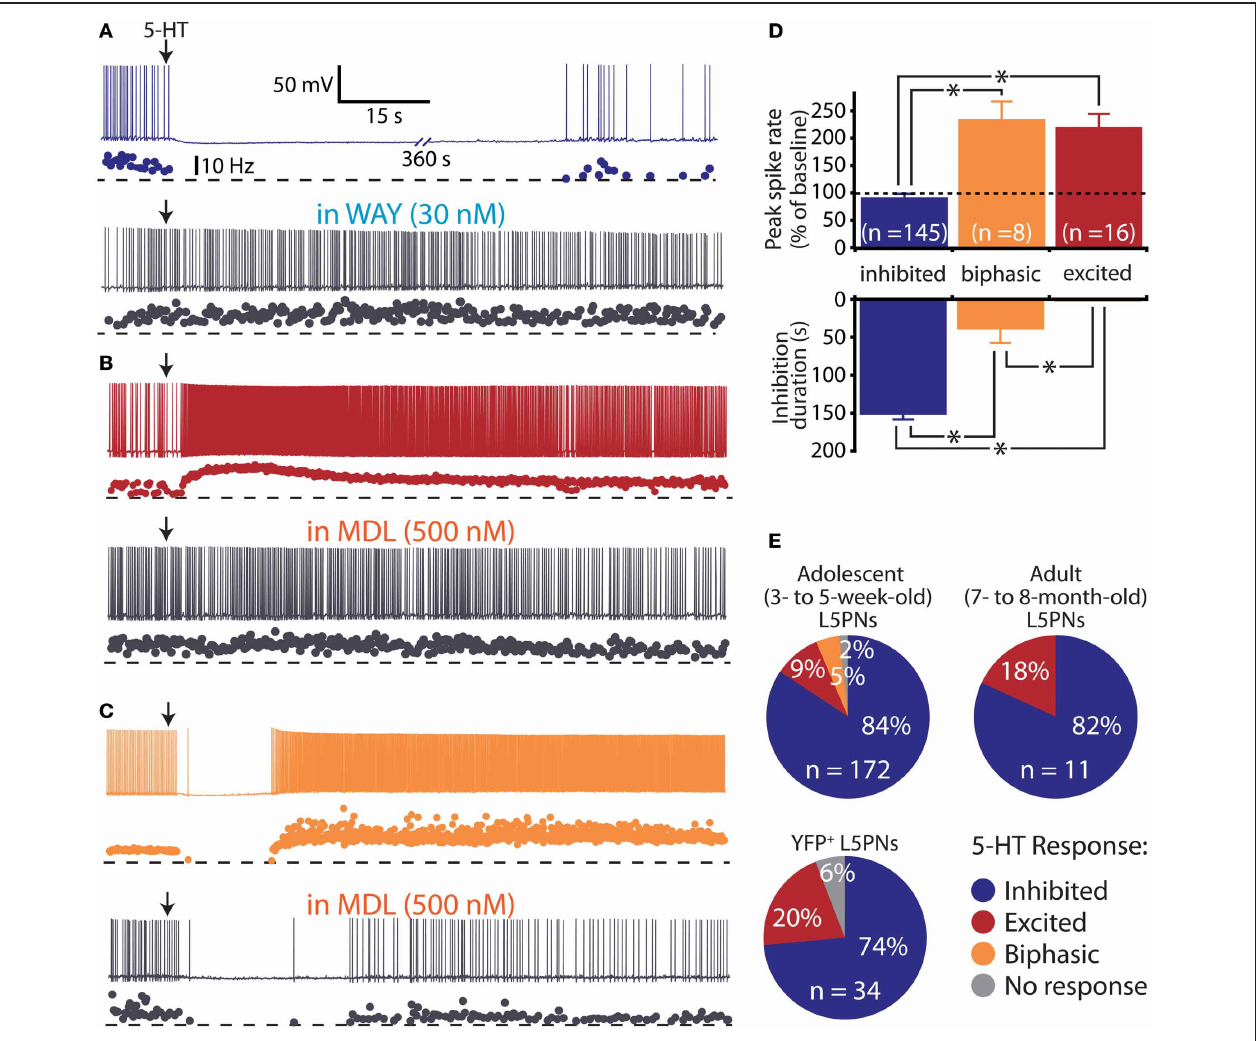
FIGURE 1 | Diversity of serotonin responses in prefrontal layer 5 pyramidal neurons (L5PNs). (A–C) Responses to focal serotonin application (100 µ M, 10s, beginning at arrow) in L5PNs during periods of current-driven action potential generation. Three response types were observed: inhibition, blocked by the 1A antagonist WAY 100635 (A) , excitation, blocked by the 2A antagonist MDL 11939 (B) , and biphasic responses consisting of short-duration inhibition followed by excitation,